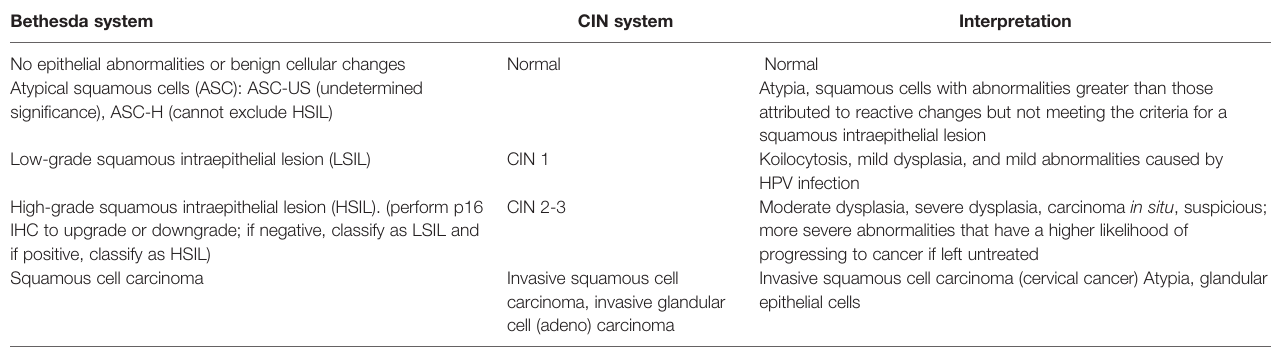
TABLE 4 | Cytology and histology for HPV-associated squamous lesions of the cervix. Bethesda system